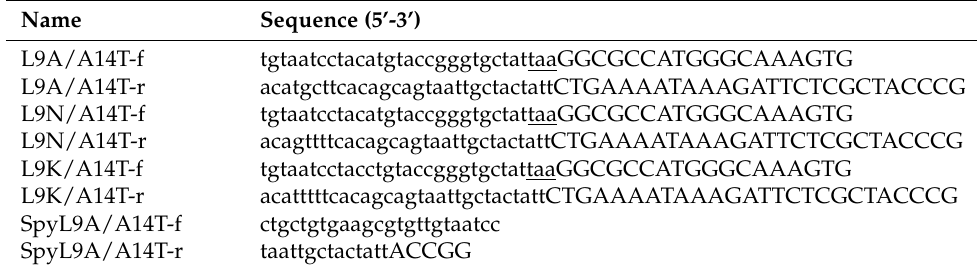
Table 1. List of primers used to generate expression vectors for double mutant STh peptides. Vector sequences are shown in upper case, STh variant coding sequences in lower case, and stop codons are underlined.